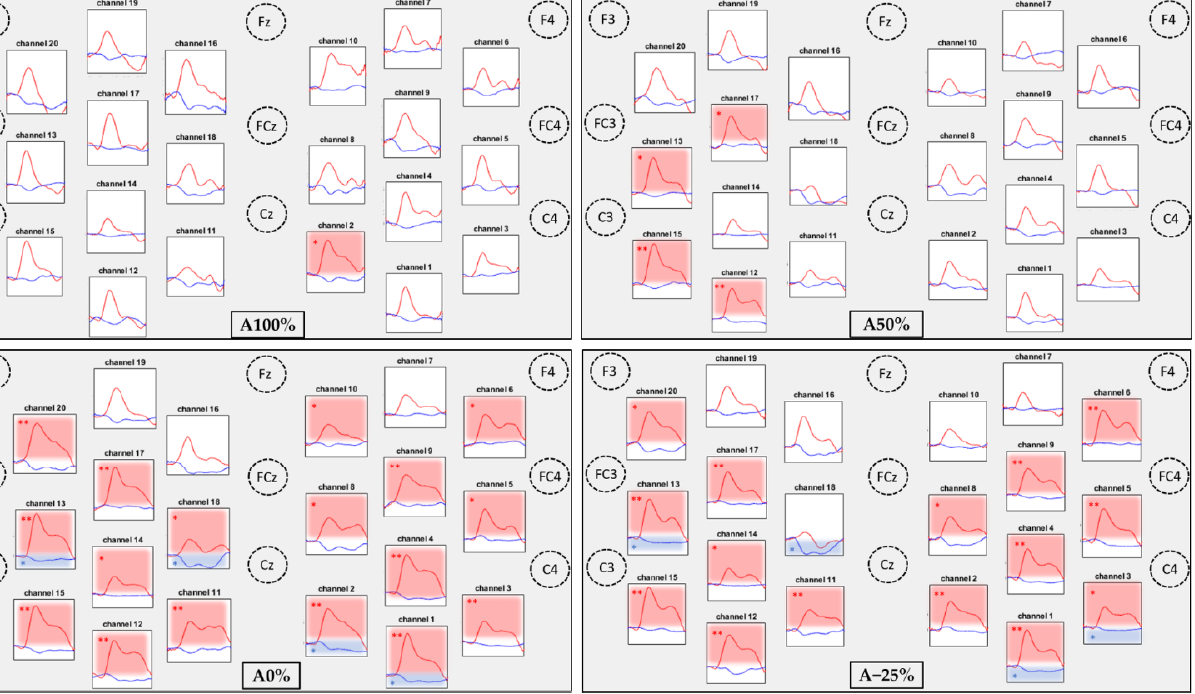
Figure 4. Mean activation maps of cerebral cortex for HbO 2 and HbR during gait for each level of assistance (A100%, A50%, A0%, A−25% ). The data are t values, t: statistical value of sample t-test with a significance level of p < 0.05 (Benjamini – Hochberg correction). The change from red to yellow indicates that the degree of activation is from low to high. The coordinates in the figure show the